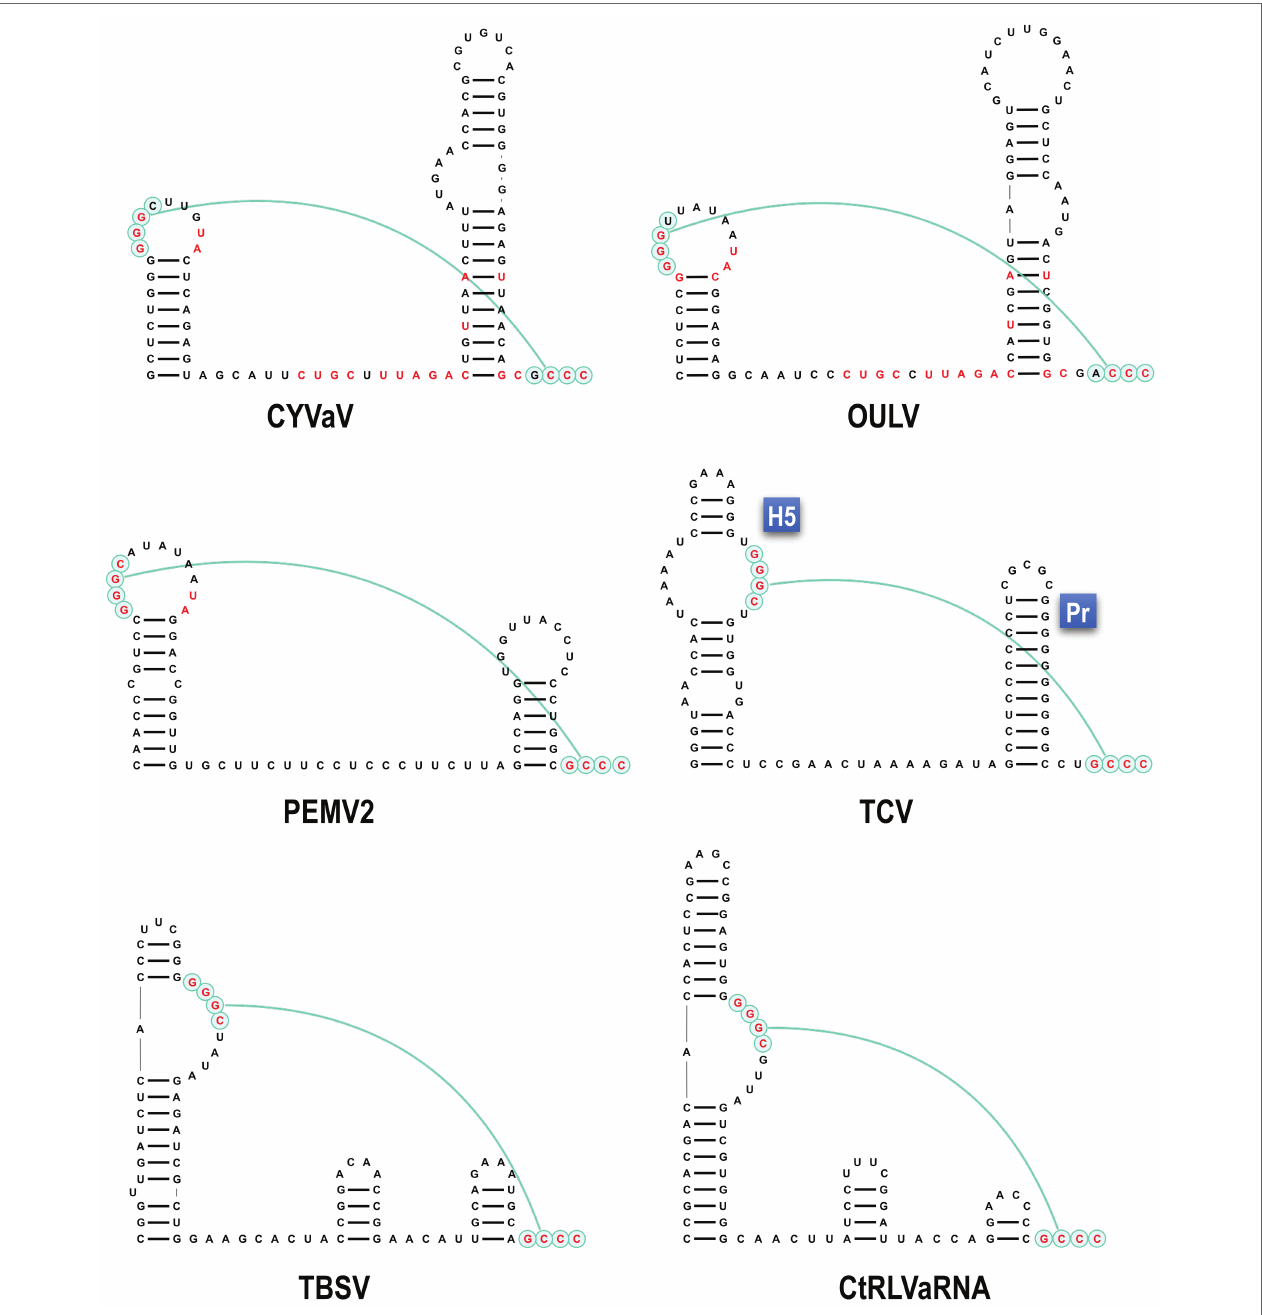
FIGURE 4 | Comparison of 3 ' terminal features between CYVaV, OULV, and selected viruses in the Tombusviridae and tombusvirus-like associated RNAs (tlaRNAs). Known structures in Umbravirus; PEMV2, Carmovirus; TCV, and Tombusvirus; TBSV and predicted structures in CYVaV, OULV, and the tlaRNA, carrot red leaf virus associated RNA (CtRLVaRNA), are shown. Similar sequences are in red. Pseudoknot is in blue. H5, penultimate hairpin; Pr, 3 ' terminal hairpin.